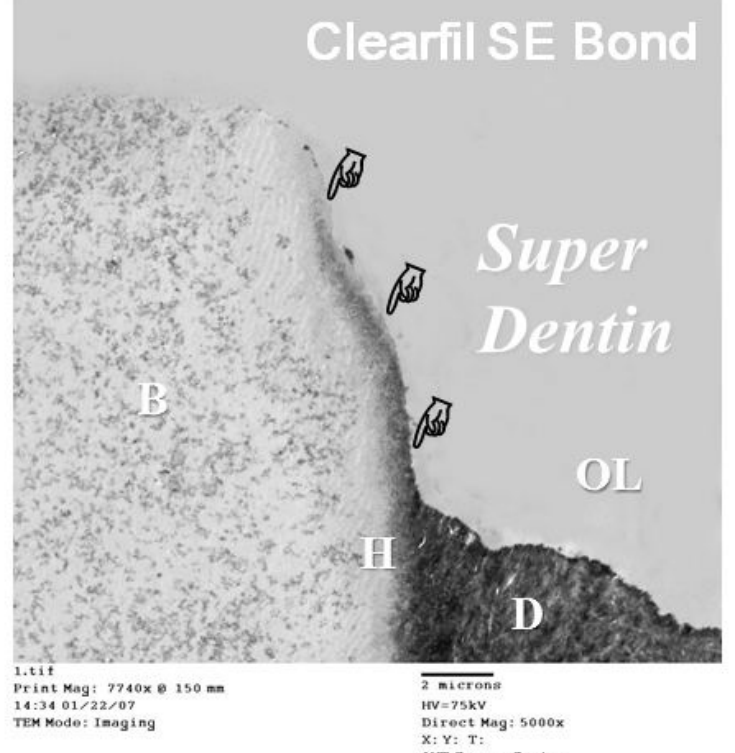
Figure 4. TEM image of the interface between a two-step self-etch adhesive system (Clearfil SE Bond, Kuraray Noritake Dental, Tokyo, Japan) and dentin after acid-base challenge. The specimen was first subjected to 100 mL buffered demineralizing solution (pH 4.5, 2.2 mmol/L CaCl , 2.2 mmol/L NaH PO and 50 mmol/L acetic acid) for 90 min 2 2 4 to create artificial secondary caries, and then to 5% NaClO for 30 min to remove any denatured collagen fibrils. The ABRZ with apatite crystallites (“Super Dentin”) were expected to be continuous with the dentin. Magnification;  7740, B; bonding resin, H; hybrid layer, D; dentin, OL; outer lesion